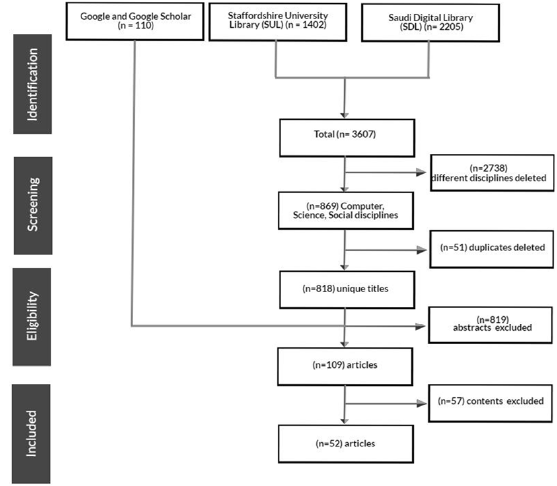
Figure 1. PRISMA Flowchart, adapted from Liberati et al. (2009) [22].